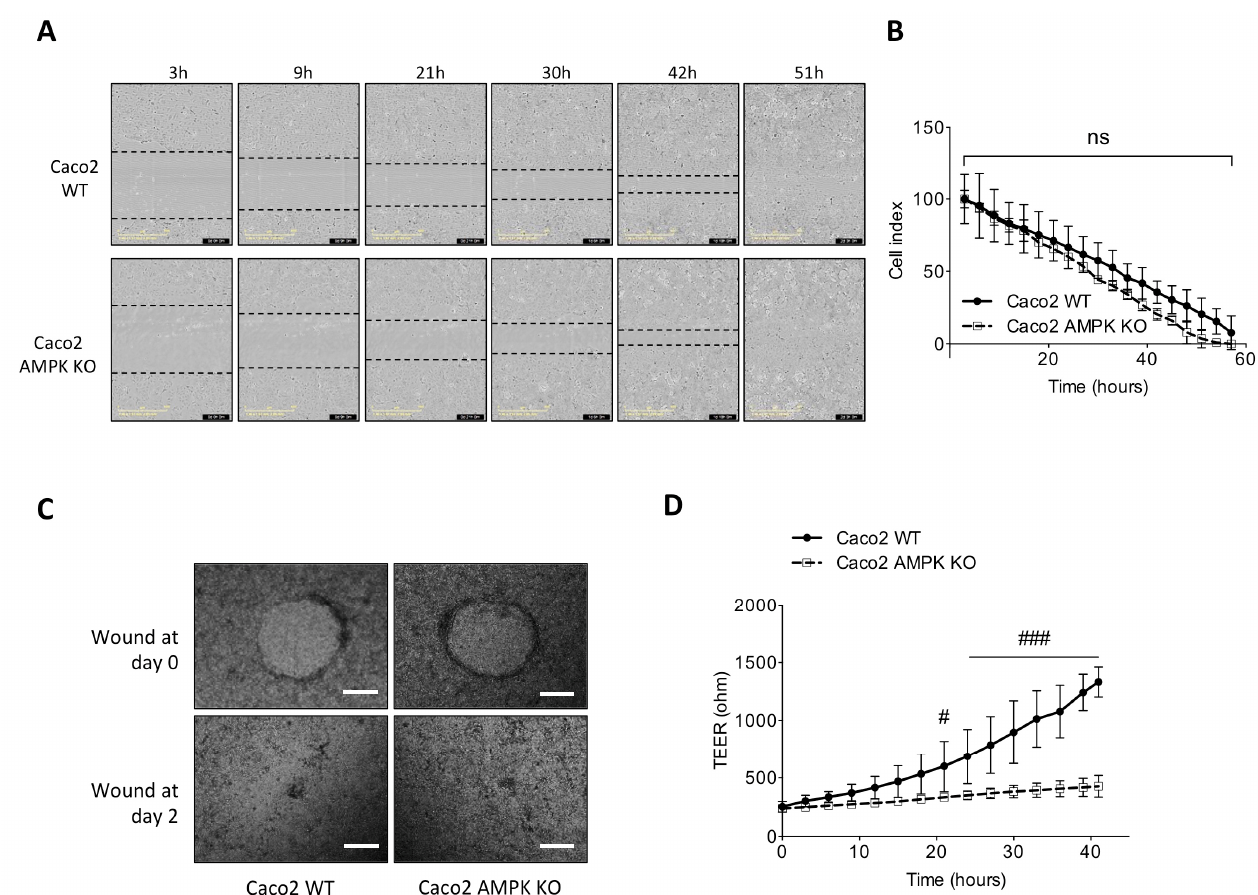
Figure 4. Altered cell spreading in AMPK-deficient Caco2 cells. ( A ) Representative acquisitions of monolayer of WT and AMPK-deficient Caco2 cells after wound scratch. Wound delimitations are indicated with dotted lines. Pictures are representative of two independent experiments performed in triplicate. ( B ) Quantification of relative wound width between WT and AMPK-deficient Caco2 cells was assessed by measuring the distance between the boundaries of the migrating cells over time. The results are representative of two independent experiments performed in triplicate. ( C ) Representative image of wound closure two days after injury on polarized confluent WT and AMPK-deficient Caco-2 cells. Pictures are representative of 20 wounds (4 wounds/transwell, 5 transwells per condition) from three independent experiments (scale bars = 200 μ M). ( D ) Variations of TEER during wound closure upon damage on polarized confluent WT and AMPK-deficient Caco-2 cells. The results are pooled from 5 transwells per condition in three independent experiments. Data are expressed as means ± SD. Statistical analysis was performed by using two-way ANOVA with Bonferroni post hoc test; # p < 0.05 and ### p < 0.001 indicate a significant difference between genotype; n.s. not significant.